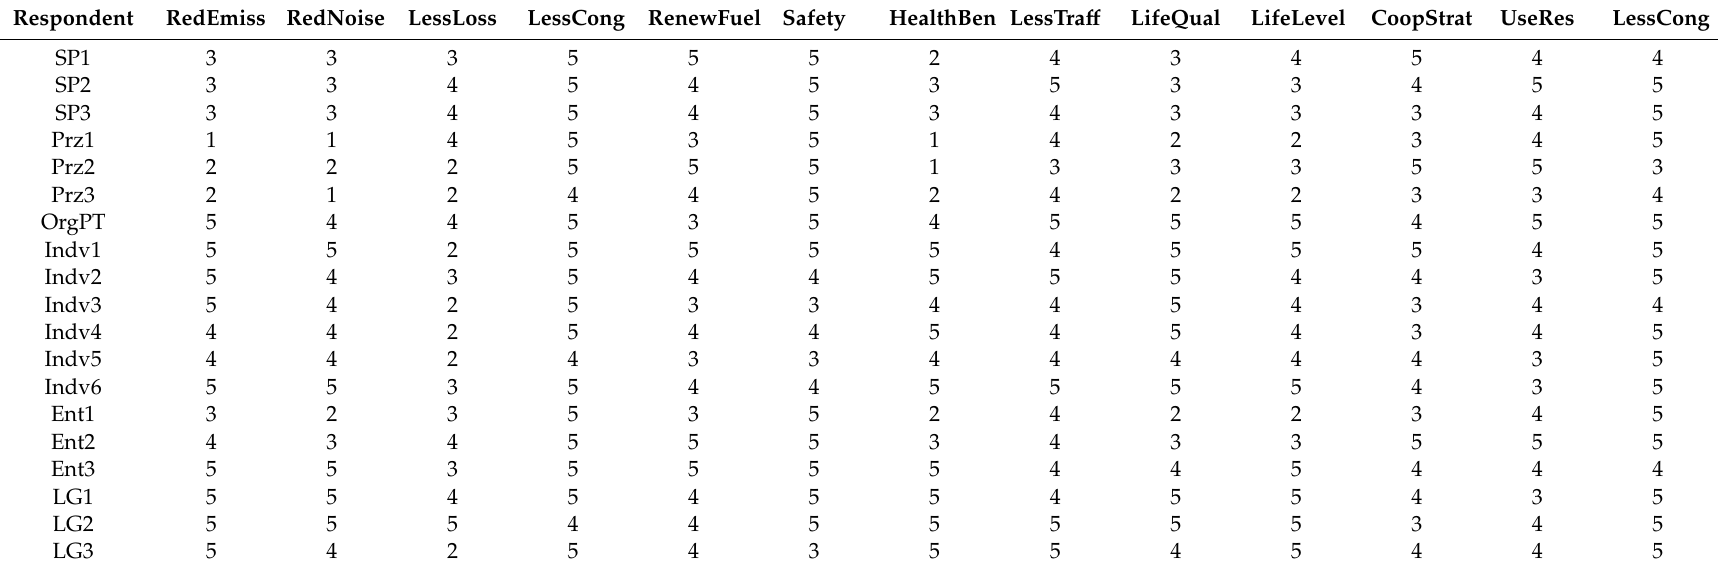
Table A1. Criteria assessment